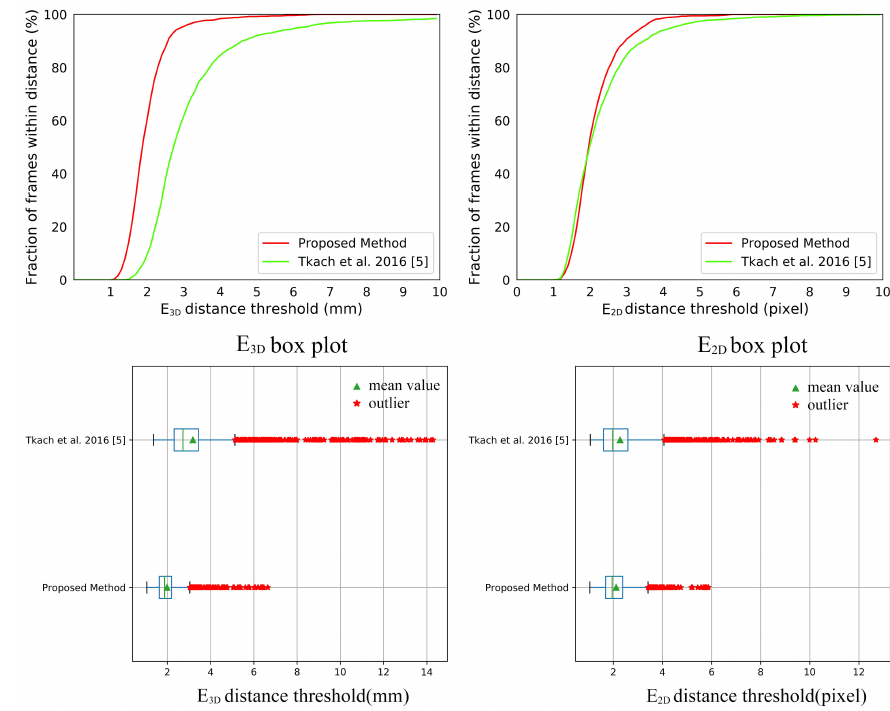
Figure 17. The E 3 D and E 2 D results of comparison between our system with [5] on Handy/ Teaser sequence.